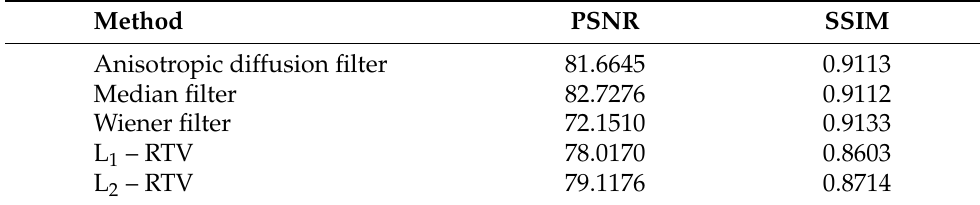
Figure 7. Five noise reduction methods used, ( a ) anisotropic diffusion filter, ( b ) Median filter, ( c ) Wiener filter, ( d ) and ( e ) are L 1 and L 2 total variation smoothing, respectively. Table 2. Quality